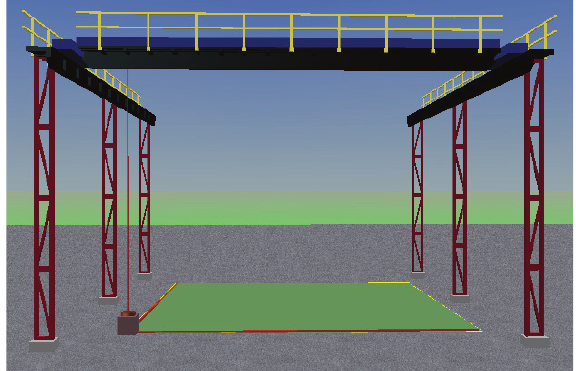
Figure 8: Applet at the client